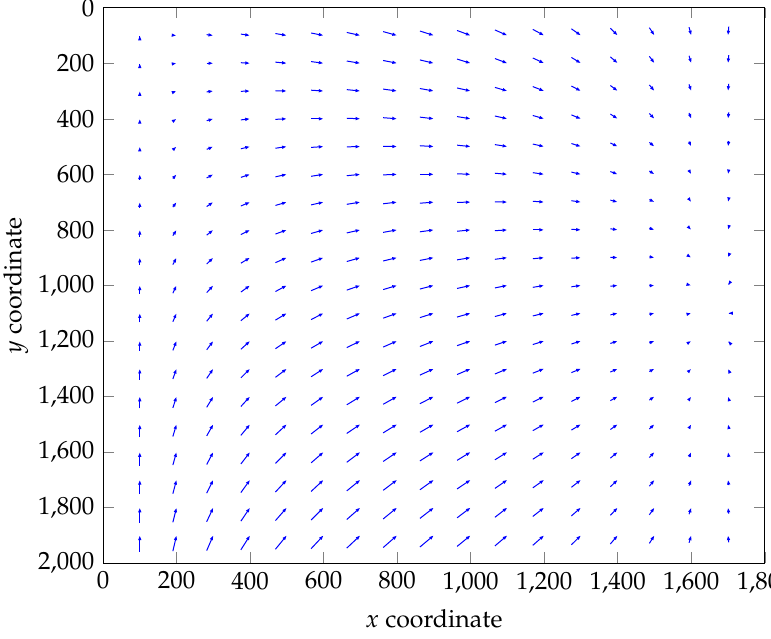
Figure 3. Vector field of both the x -axis and y -axis corrections. The origin of each vector is ( h ( x , y ) ,v ( x , y )) , and its end is ( x , y ) . For clarity, only vectors whose final coordinates ( x , y ) are multiple of 100 are shown here.